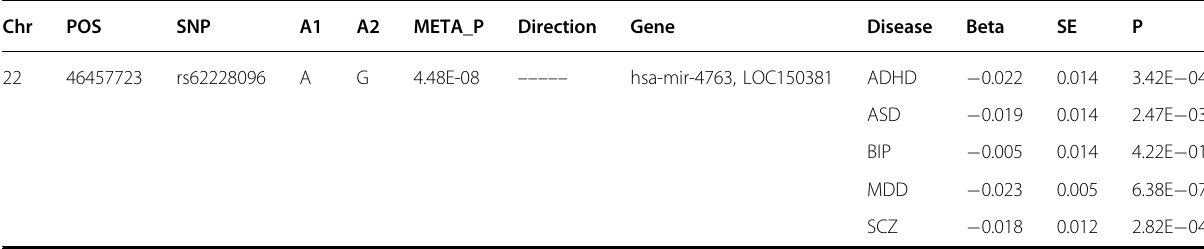
Table 2 Novel locus from a meta-analysis of fi ve neuropsychiatric disorders. Chr